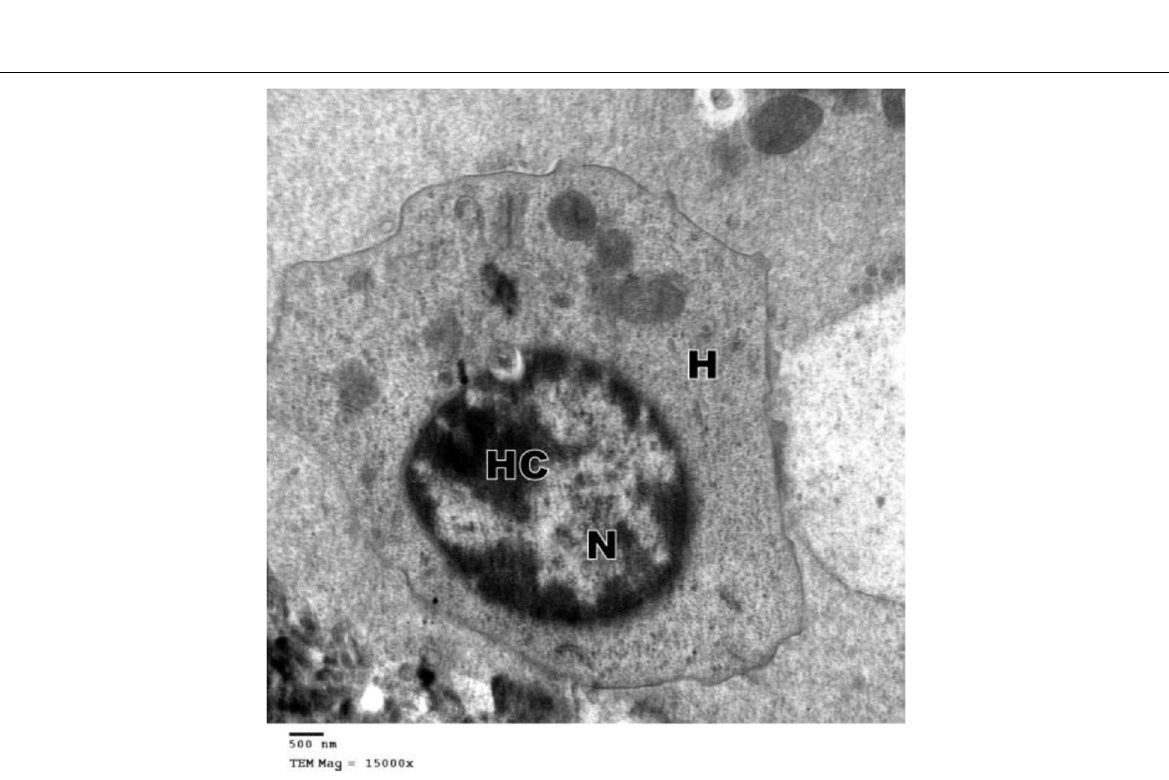
Fig. 18 An electron micrograph of a hepatocyte of treated mouse with Tamiflu (16 mg/kg b.wt.) for 15 days revealing shrinked hepatocyte (H) lost most of its content and possesses a nucleus (N) with dense heterchromatin (HC) attached to its inner membrane of nuclear envelope. (×